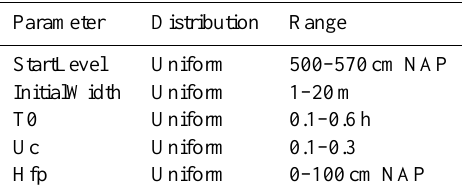
Table 2. Distribution and range of uncertainty estimates for param- eters related to the breach formation and growth a